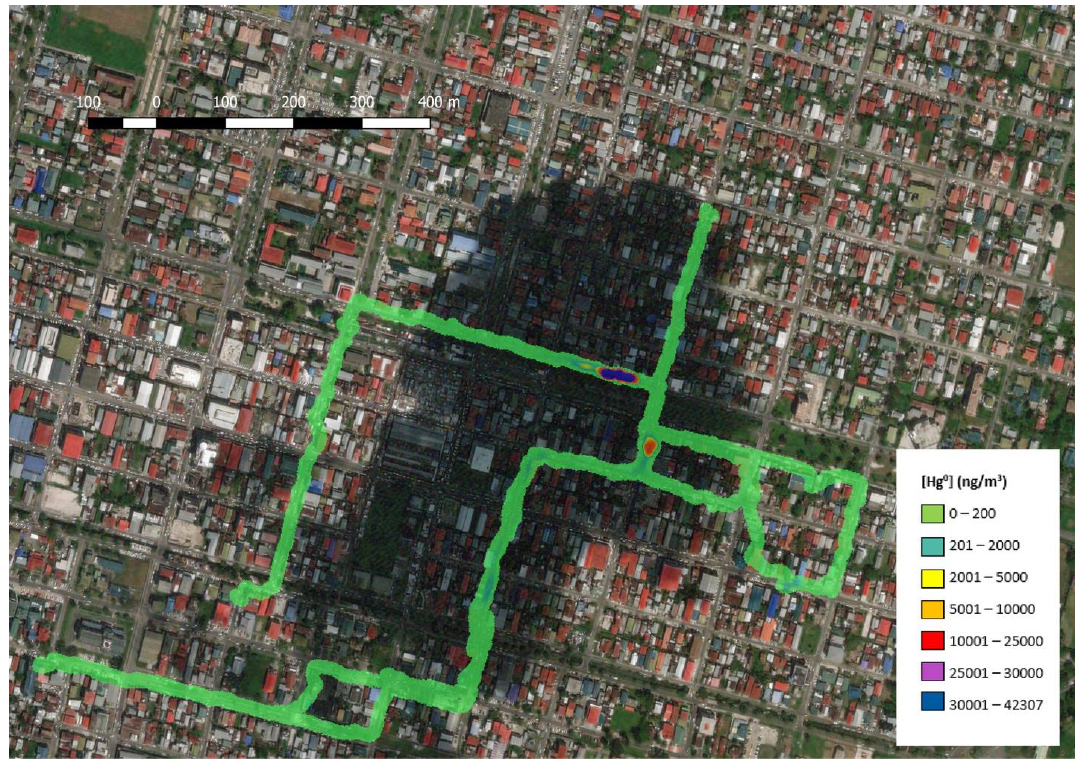
Figure 2. Map generated of elemental mercury (Hg 0 ) concentrations during phase one of training in Georgetown, Guyana. Table 2. Benchmark [Hg 0 ] in air and corresponding